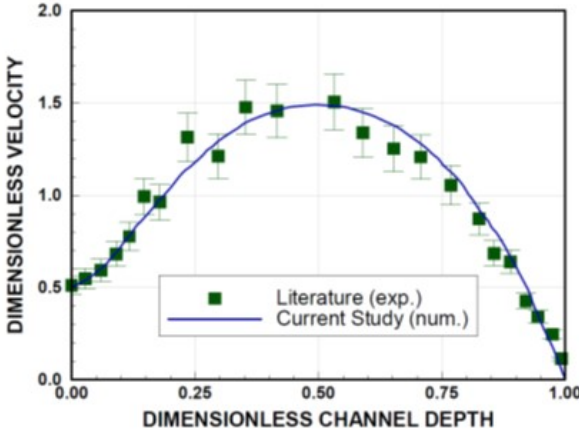
Figure 2. Model validation by comparison with experimental work from literature.